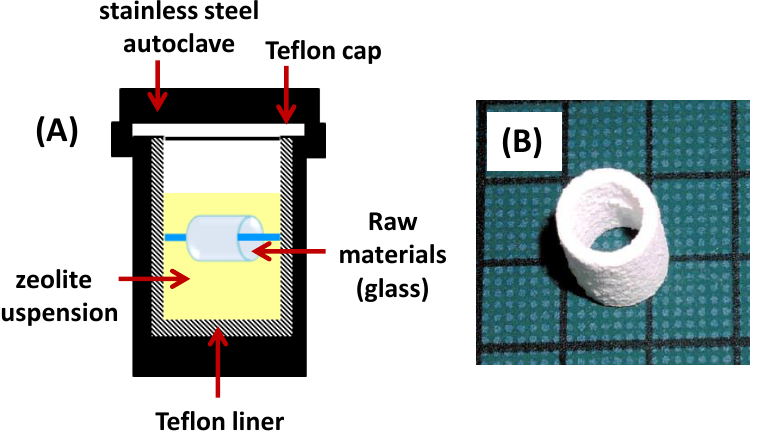
Figure 4. ( A ): Schematic illustration of the synthesis route for bulk material dissolution technique under static condition; ( B ): obtained monolith [87].